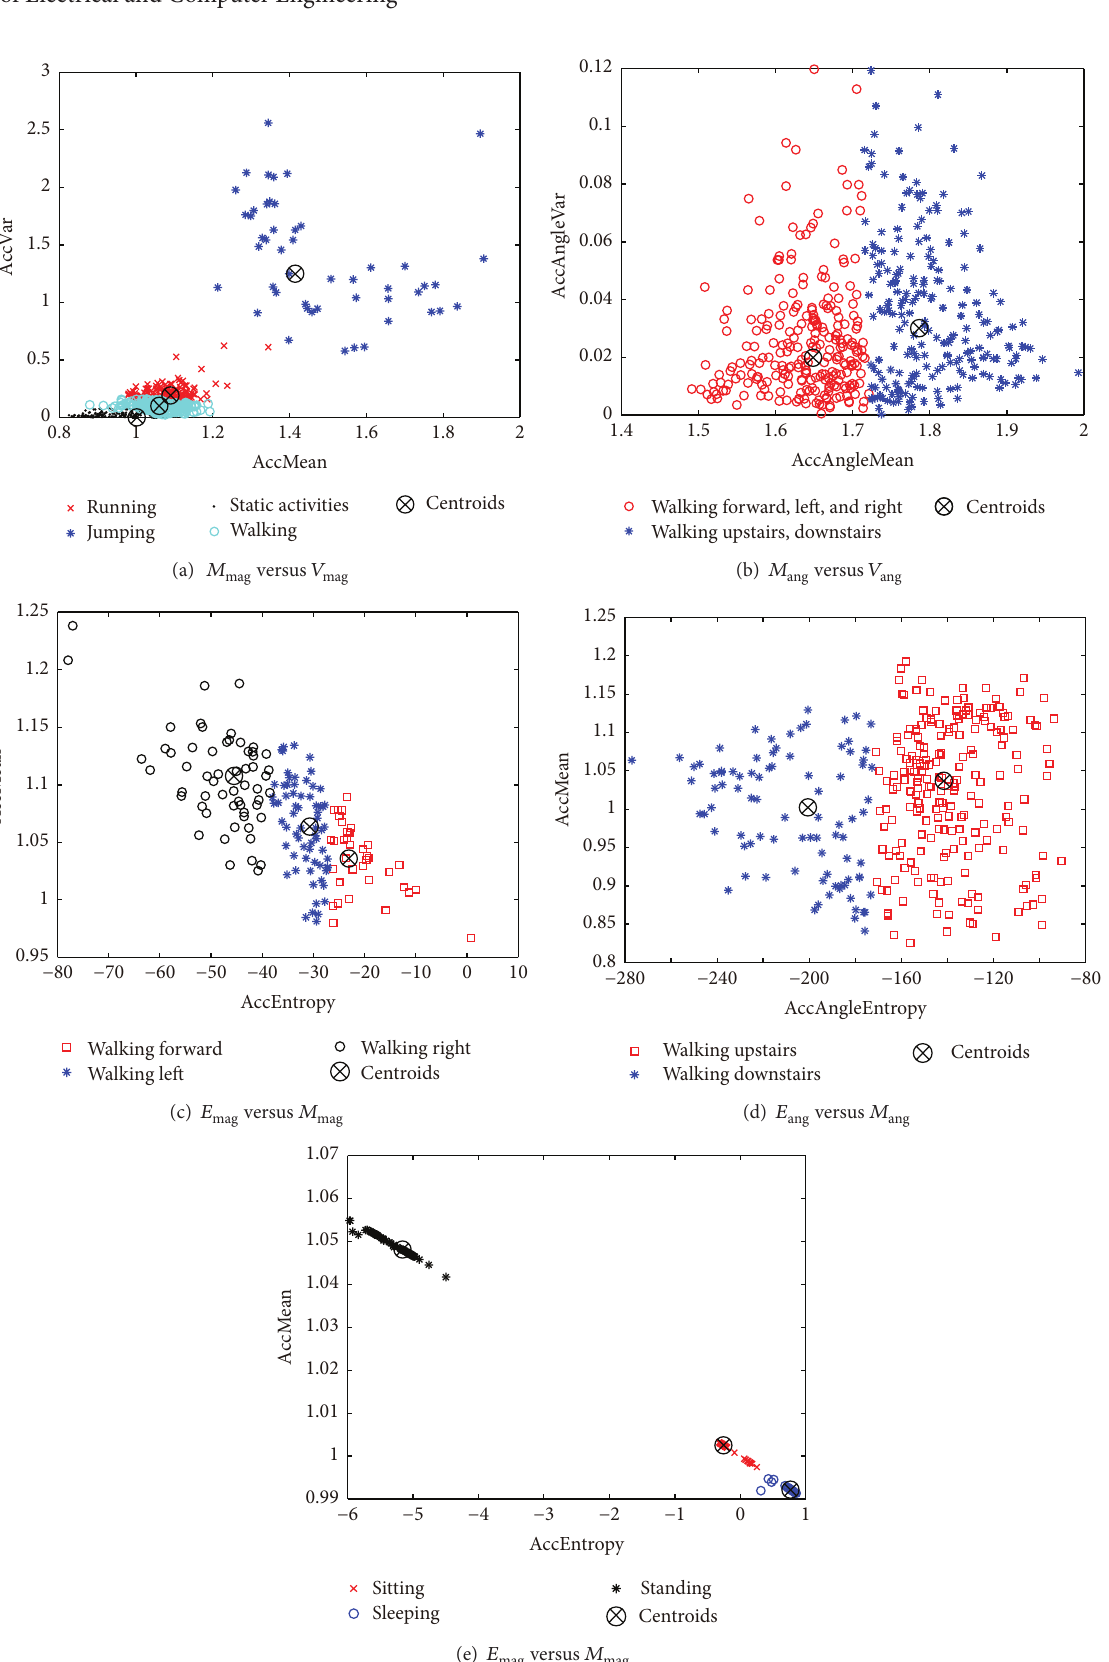
Figure 2: Scatter plots in the 2D feature space ( 𝑇 = 50